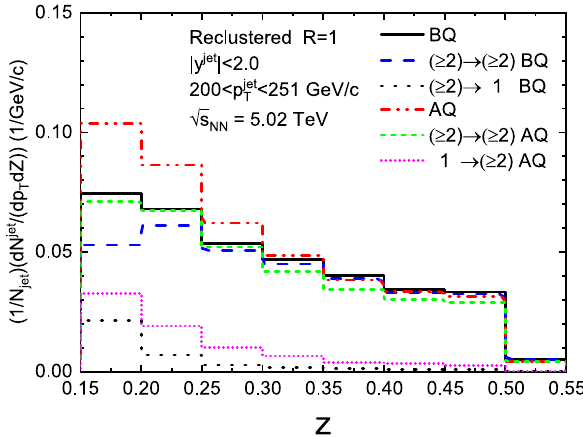
Fig. 10 Contributions from different processes to reclustered LR jet distributions as a function of the hardest jet splitting function z of vac- uum and medium-modified reclustered LR jets at